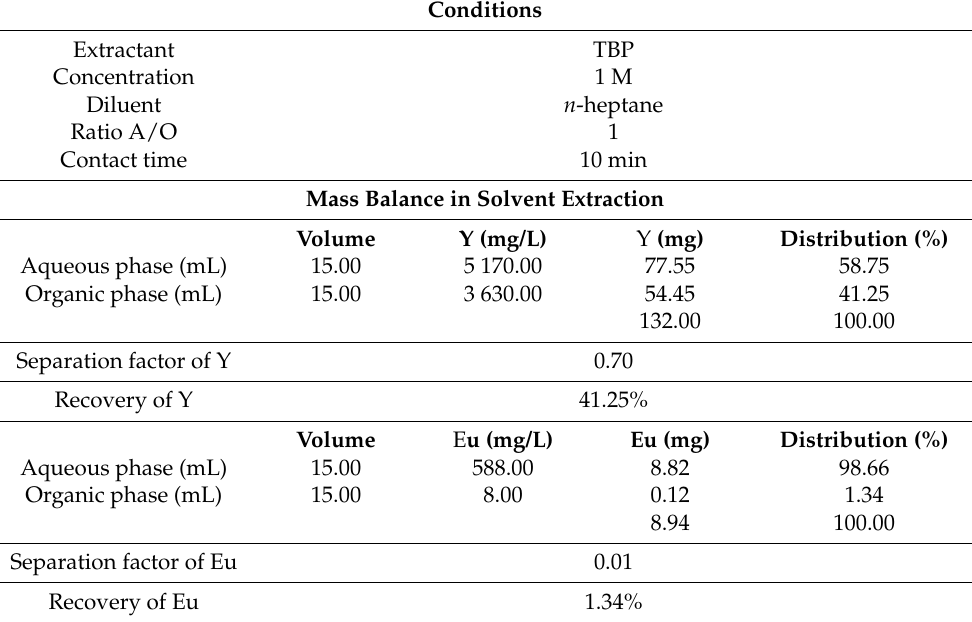
Table A2. Europium and yttrium recovery and separation factor with